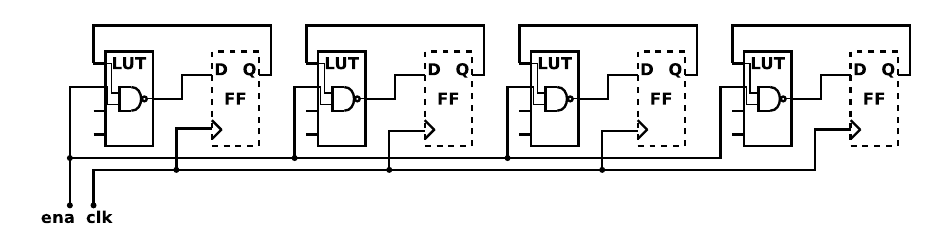
Figure 2: Generic schematic of an artificial noise generation grid based on ROs or toggling